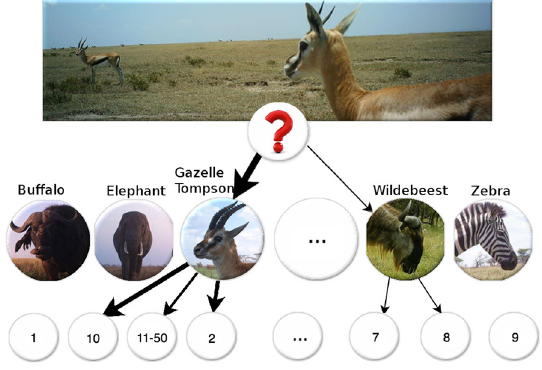
Figure 1. Classi fi cation tasks from